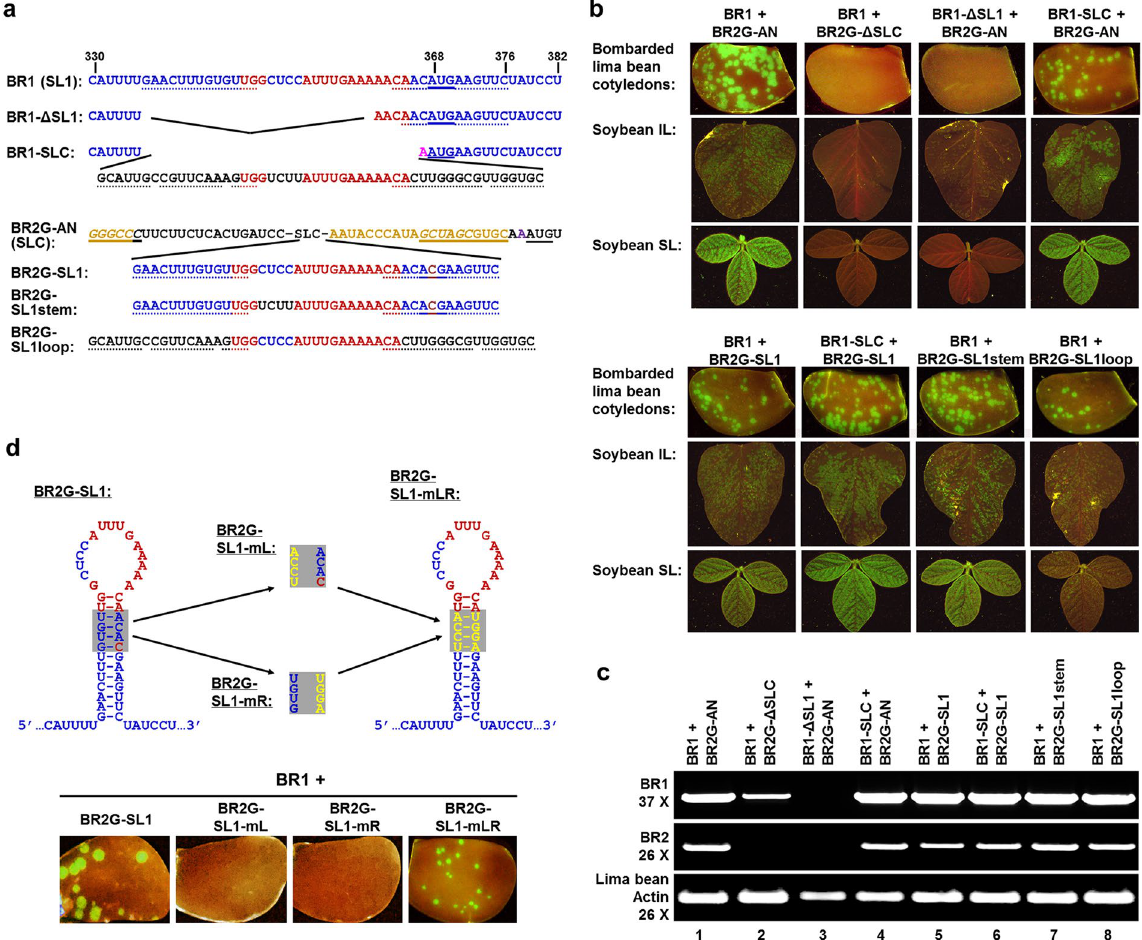
Figure 3. SL1 and SLC of BPMV are interchangeable. ( a ) Sequences of the SL1 and SLC portions of BR1 and BR2G-AN, respectively, and their deletion/replacement mutants. SL1 and SLC sequences are in blue and black letters, respectively; with the conserved loop nts in red. The nts involved in stems are underlined with dots. The AUG start codon in SL1, and its mutated form (ACG), are underlined with solid lines. Note that the last fifteen and nine nts of SL1 were retained in BR1- Δ SL1 and BR1-SLC, respectively, to preserve the AUG translational start codon. In BR2G derivatives containing SL1 segments, the AUG within the SL1 stem was changed to ACG to avoid its potential translational conflict with the RNA2 start codon downstream. ( b ) Lima bean cotyledons bombarded with various mutants, along with IL and SL images of soybean infected with the corresponding viruses. ( c ) RT-PCR detection of BR1 and BR2G RNAs in lima bean cotyledons bombarded with the mutants. ( d ) The stem of SL1 needs to remain base-paired in order for SL1 to be functional. Top: the predicted structure of SL1 in BR2G backbone, along with the three mutations (mL, MR, and mLR) introduced into the shaded area of the stem. Both mL and mR were predicted to disrupt the stem, whereas mLR should restore the base pairs with different sequences. Bottom: lima bean cotyledons bombarded with the constructs indicated above showing the restoration of replicability by the mLR